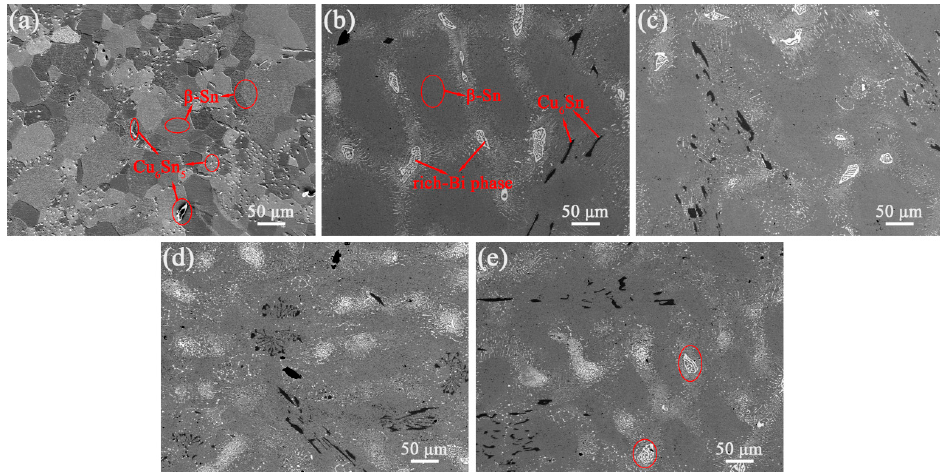
Figure 3. Microstructure of ( a ) Sn-0.7Cu, microstructure of Sn-0.7Cu-10Bi-xCr: ( b ) 0.05 wt.%, ( c ) 0.1 wt.%, ( d ) 0.2 wt.% and ( e ) 0.3 wt.%.